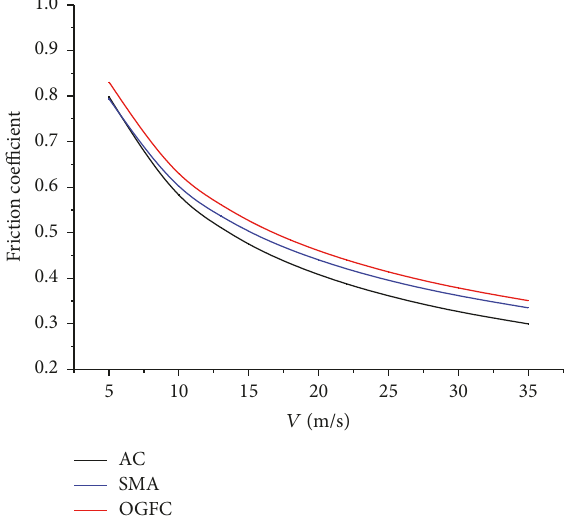
Figure 4: Kinetic friction